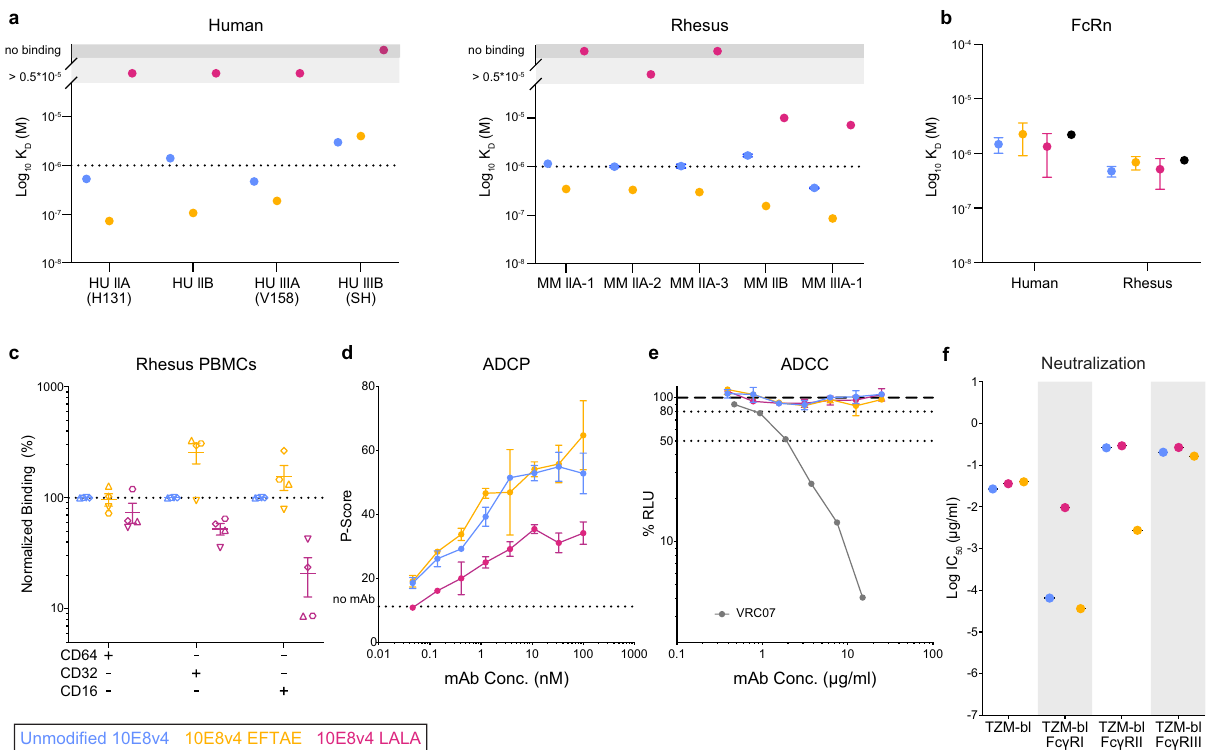
Fig. 2 Fc variant EFTAE increases af fi nity for Fc γ RII and Fc γ RIII but does not alter ADCP or lack of ADCC activity. a Kinetic af fi nity constants for recombinant human and rhesus macaque Fc γ RII and Fc γ RIII encoded by the indicated allelic variants determined by SPR. Dotted lines represent the highest concentration tested, above which con fi dence in fi tted equilibrium dissociation constants is diminished. b Kinetic af fi nity constants for recombinant human and rhesus FcRn determined by SPR. Black symbols denote values of an isotype-matched mAb. c Fluorescently labeled antibody binding to naive PBMCs from n = 4 rhesus macaques determined by fl ow cytometry. Data are reported as the percent binding of Fc variant 10E8v4 relative to unmodi fi ed 10E8v4 for each macaque designated by matched symbols. d ADCP activity of 10E8v4 measured by THP-1 monocyte internalization of MPER peptide-coated fl uorescent beads. e ADCC activity against SHIV SF162P3 -infected target cells expressing luciferase reporter, with activity measured as the loss in relative light units (RLU). CD4bs bNAb VRC07 is shown as a positive control. f Neutralization of SHIV SF162P3 pseudovirus using parent TZM-bl or those transduced for surface expression of Fc γ Rs. Analyzed data shown in a – d and f are mean ± SD and mean only in e . All data reported are representative of at least two independent experiments. Source data are provided in the Source Data fi le associated with this manuscript. The color key is shown and colors are consistent throughout the manuscript. FcRn neonatal Fc receptor, PBMC peripheral blood mononuclear cell, ADCC antibody-dependent cellular